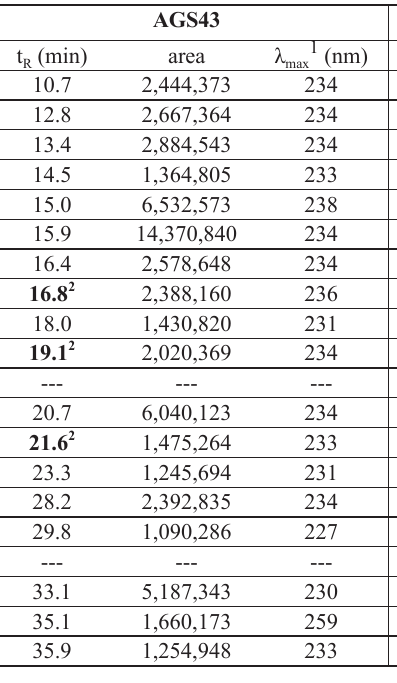
1 all spectra presented one band. 2